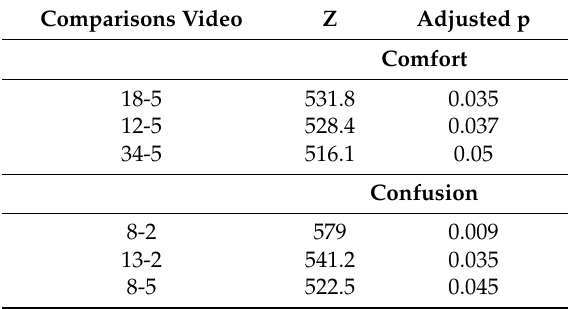
Table 7. Statistically significant results of the post hoc Dunn test of the ratings grouped per